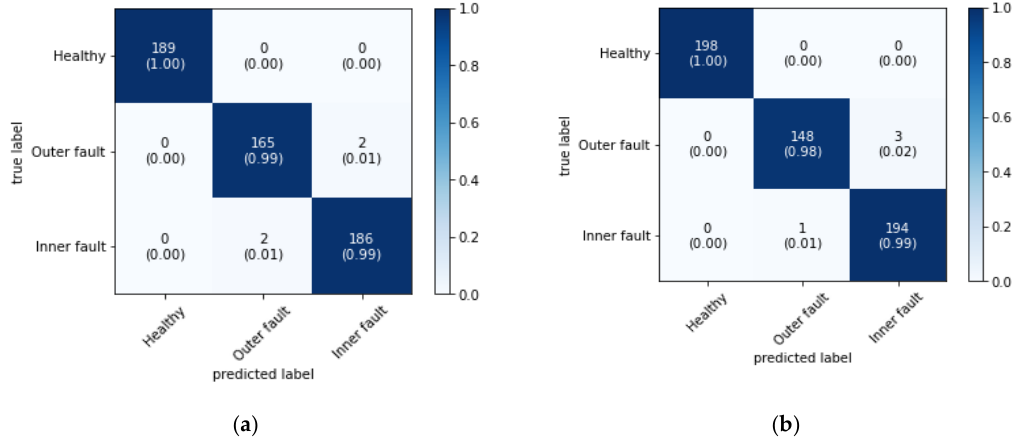
Figure 13. Confusion matrix of the db4 wavelet for ( a ) RF and ( b ) XGBoost classifiers.